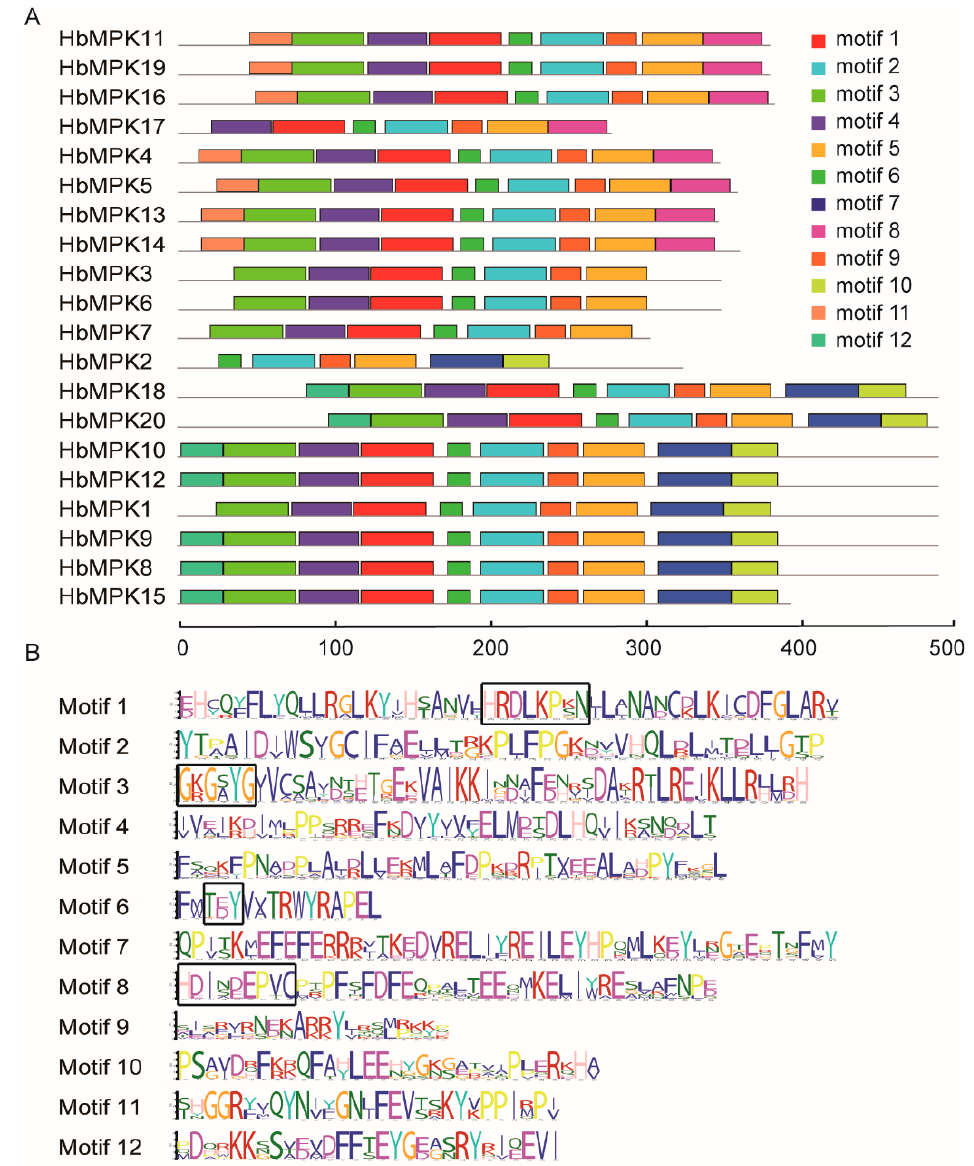
Figure 4. Motif analysis of the MPK family members in Hevea . ( A ) Motif distributions for 20 HbMPKs. Rectangles with different colour represent 12 recognised conserved motifs; ( B ) Detailed information (amino acid sequence) of the 12 motifs. The heights of each letter represent the frequency of amino acids at that position, and the black boxes indicate the key sites of the four conserved motifs.